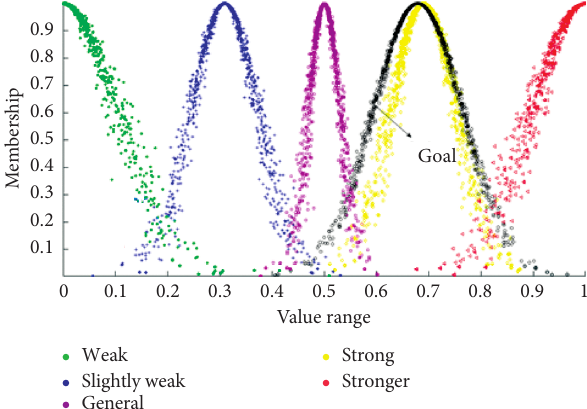
Figure 10: The cloud model evaluation results chart of